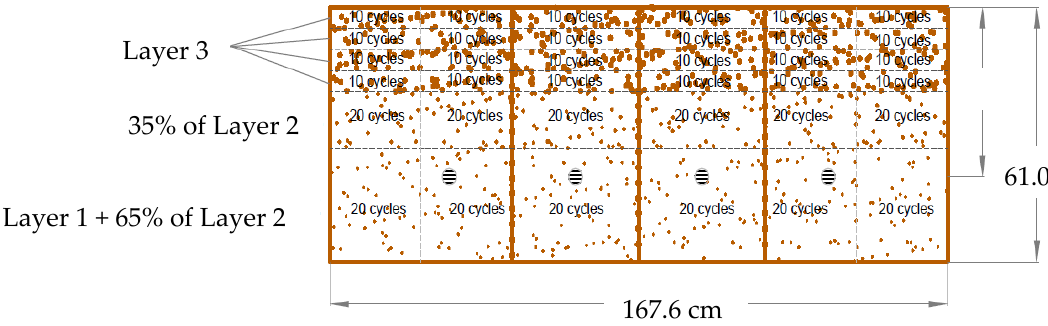
Figure 5. Compaction pattern.